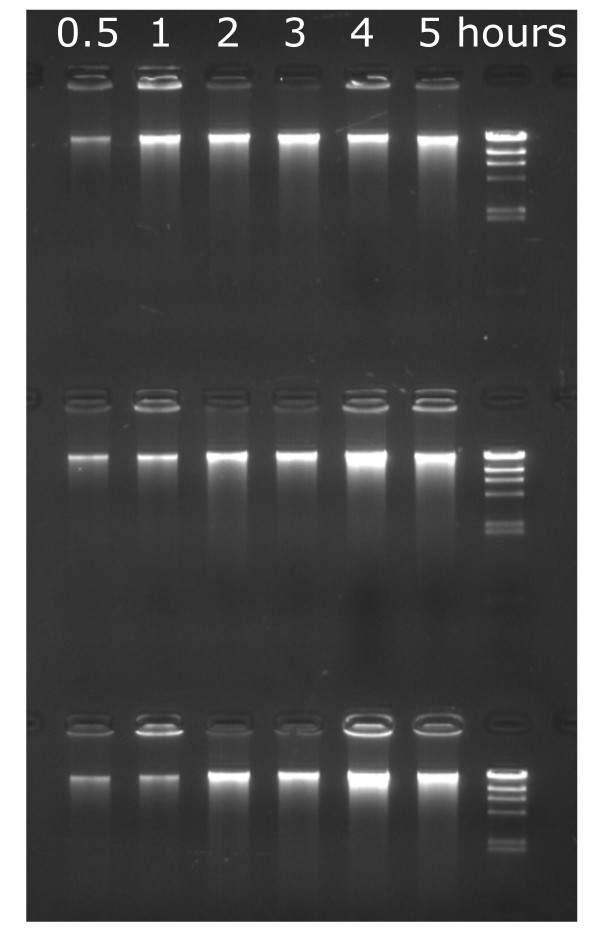
Time scale DNA release from digesting leaf disks. Triplicate essay of time scale DNA release from leaf disks of Ilex aquifolium at 0.5 to 5 hours of enzymatic digestion. Size marker: lambda/HindIII DNA.